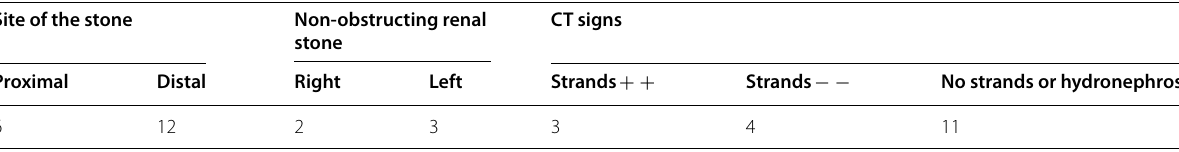
Table 1 Summary of the site of the stone and CT